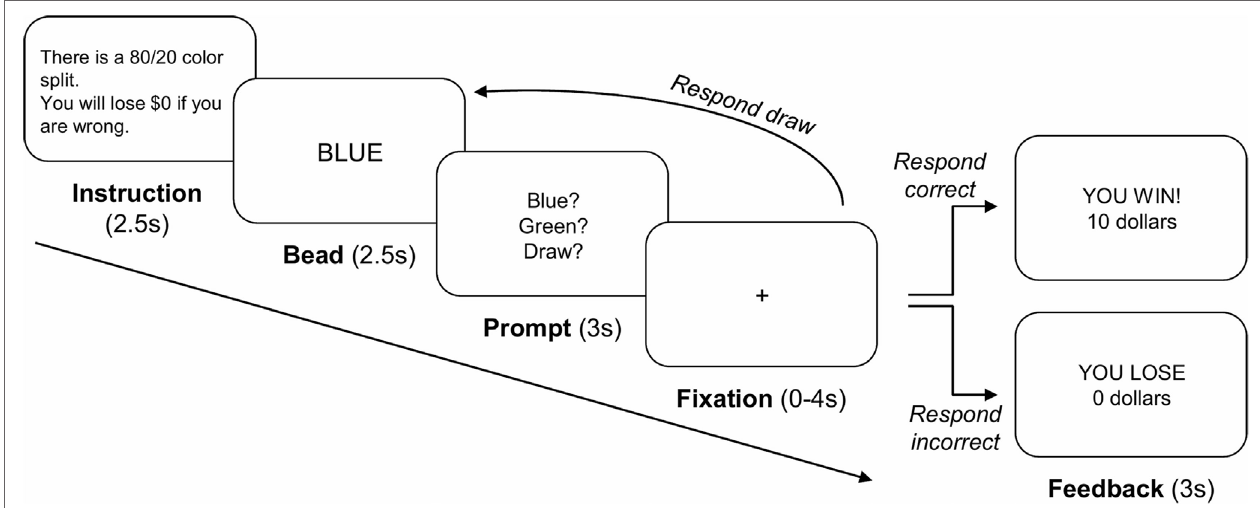
FigUre 1 | Overview of the beads task. Each sequence started with an instruction screen showing the proportion of bead colors in the two urns (80/20 or 60/40 color split) and the cost for an incorrect urn choice ($10 or $0). Participants then viewed a bead color and indicated that they either chose to draw another bead ($0.25 cost) or chose an urn. Upon a draw choice, another bead of the sequence was presented. Upon an urn choice, a feedback screen was presented, which displayed whether the participant chose the correct or incorrect urn and how much money they won or lost during that